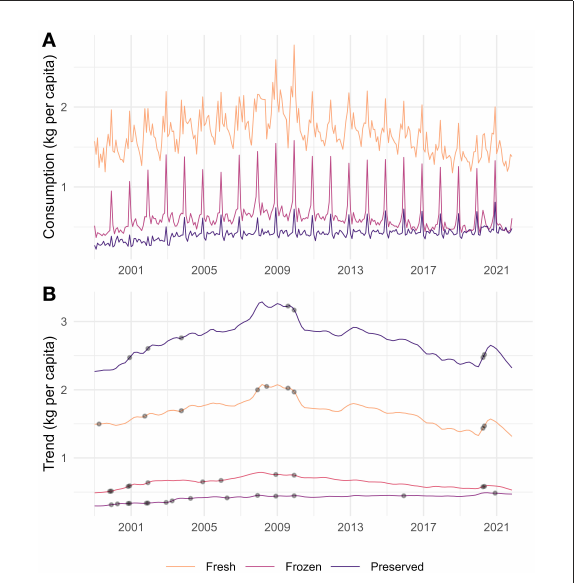
FIGURE3 (A) Monthly time series and (B) deseasonalised temporal trends of blue food consumption (kg per capita) between 1999 and 2021 by food type (fresh, frozen, and preserved). Black dots denote anomalies detected with generalised extreme studentised